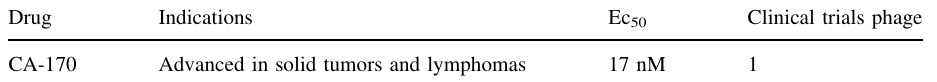
Table 2 PD(L)-1 inhibitors ongoing clinical